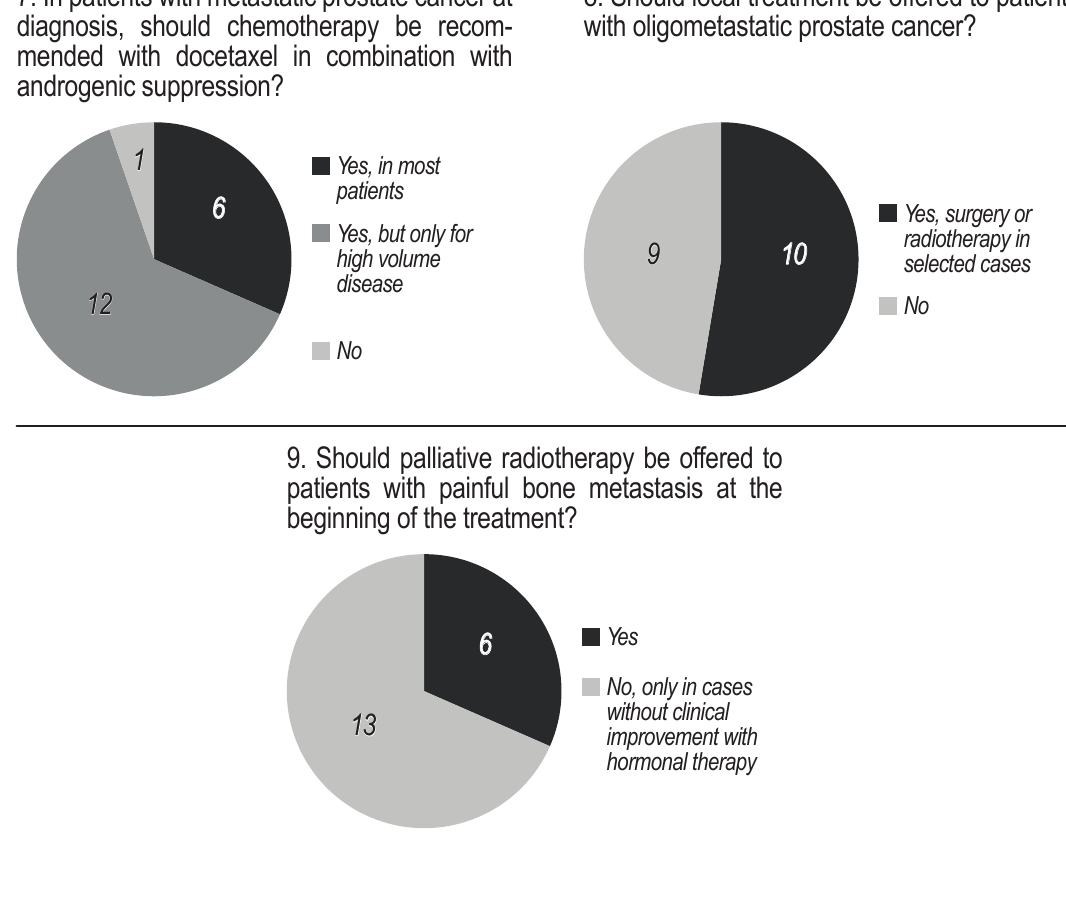
Figure 1. Votes regarding the section “Metastatic Prostate Cancer Sensitive to Castration” 154 0 1. Which of the options below should be recommended as initial androgen deprivation therapy in metastatic prostate cancer? 2. Can the use of first-generation antiandrogen (bicalutamide, flutamide) be indicated in monotherapy for the treatment of patients with metastatic prostate cancer? 3. Should the use of combined antiandrogenic therapy (LHRH analogs/antagonists plus peripheral antiandrogen) be recommended in the initial treatment of metastatic prostate cancer, excluding in the use for flare prevention? 4. What is the recommended serum concentra- tion of testosterone for defining/determining castration? 5. What therapy would be recommended in case of non-attainment of testosterone levels compatible with castration along with the use of LHRH analogs, assuming correct use of analogs and low dosage of LH? 6. Can intermittent hormonal deprivation be recommended in metastatic patients that reach adequate PSA decline (declining PSA, with less than 4.0 ng/ml after 6 months of block)?